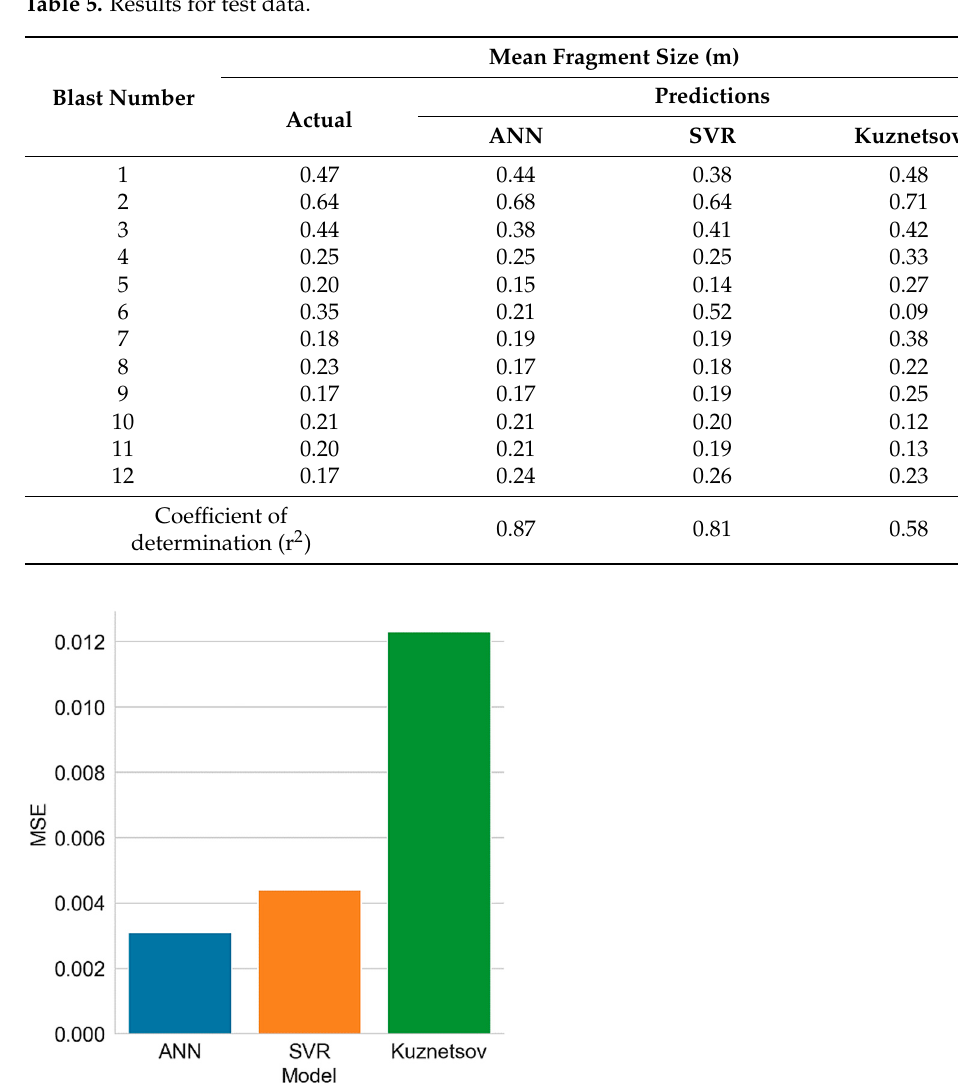
Table 5. Results for test data.